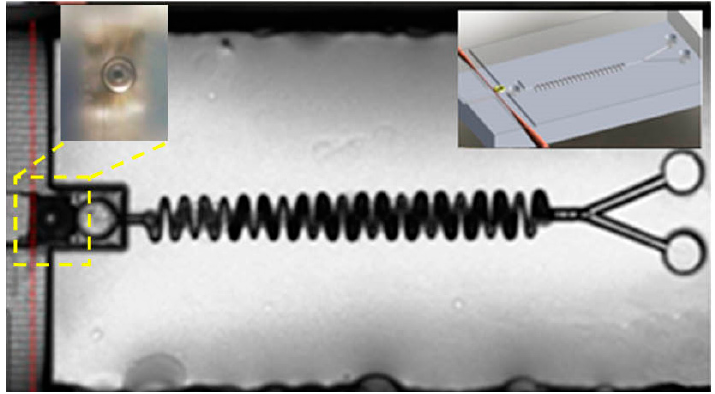
Figure 12. The fabricated optofluidic refractive index sensor. The fiber is indicated with the dashed red line, and the microtoroid resonator is indicted with a yellow square. Inset ( right ): Illustration of the layout of the integrated optofluidic sensor. Inset ( left ): The close-up view of the assembled microtoroid-fiber system fabricated in the microfluidic channel using a femtosecond laser.